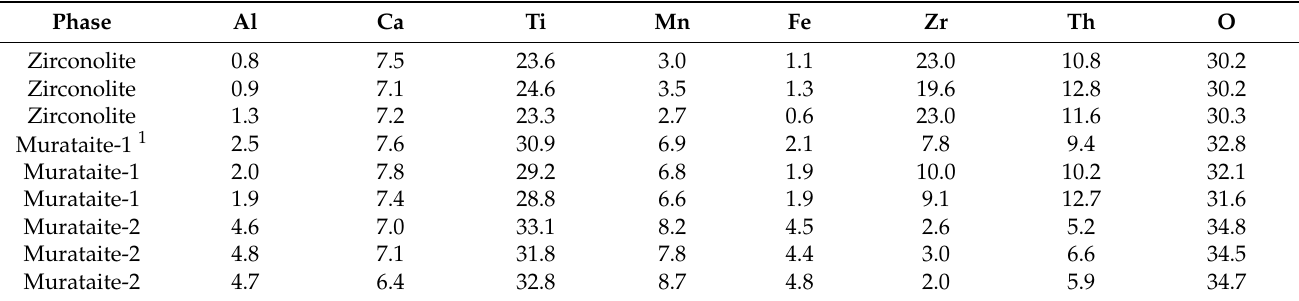
Figure 7. ( a ) X-ray powder diffraction pattern and ( b ) SEM image of sample “Th”: 1—zirconolite, 2—murataite—1, 3—murataite 2, blackp—ores. Markers on the XRD pattern show the peak positions only. The high-resolution diffraction pattern is given in Appendix A. Table 4. Phase compositions of sample “Th” ( ∑ = 100 wt.%, SEM/EDS data).